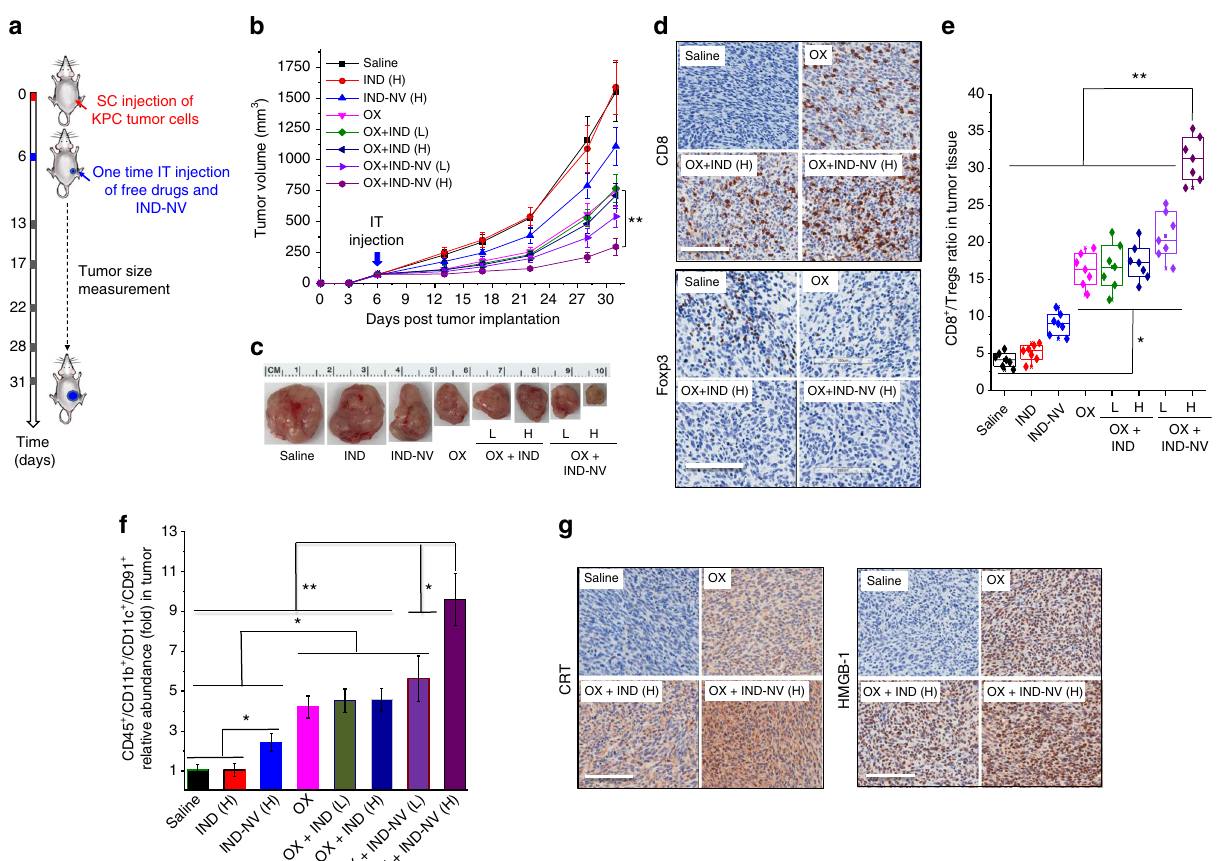
Fig. 4 Co-administration of IND-NV with OX at the tumor site augments anti-PDAC immunity. a Local co-administration in KPC tumors established by SC injection in syngeneic mice. Treatment details are provided in the methods section. b KPC tumor growth curve after a single IT injection of the various drugs at a tumor size of 60 – 80 mm 3 . OX was injected at 1.25 mg/kg 15 . Low (L, 2.5 mg IND/kg) and High (H, 12.5 mg IND/kg) refer to the IND or IND-NV doses. c Representative tumor images from each group after euthanizing the animal on day 31. d IHC depicting CD8 and Foxp3 biomarkers in the collected tumor tissue. A full set of panels of the IHC staining data are shown in Supplementary Fig. 7a – j. e Flow cytometry determination of CD8/Tregs ratio, as described in d . f Flow cytometry analysis to determine CD91 expression in the population of CD45 + /CD11b + /CD11c + cells in the tumor tissue. g IHC to depict CRT and HMGB-1 expression in the collected tumor tissues. The results are expressed as mean ± SEM. * p < 0.05; ** p < 0.01, (ANOVA). The